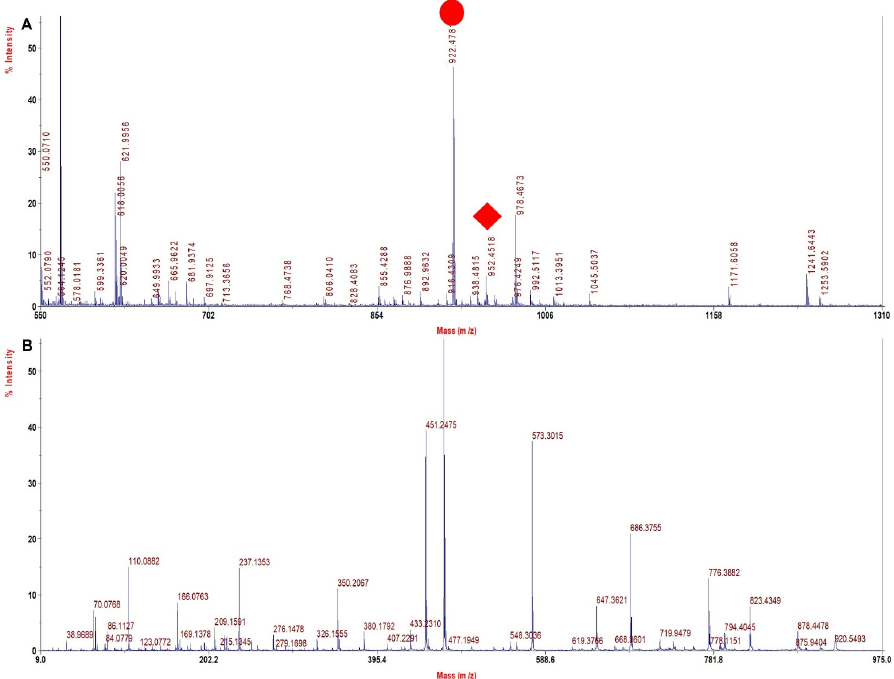
Figure 6. MALDI − MS and MALDI MS/MS spectra for the signature peptide from HbS heterozygous (1908) Beta 6 (A3) Glu > Val ( A ). PMF spectrum showing signature peptide obtained by TFE treated in − solution tryptic digestion. ( B ) MALDI − MS/MS spectrum of the signature peptide 922.4 m/z of HbS heterozygous sample. Figure 7A depicts the MS spectrum of HbS homozygous β 6 (A3) Glu > Val showing the tryptic peptide V 1 HLTPVEK 8 of monoisotopic m/z of 922.47. The MS/MS spectrum of the signature tryptic peptide VHLTPVEK is shown in Figure 7B. In β tryptic digested pep- tide VHLTPVEK of the HbS heterozygous sample, the difference between y (3 − 2 ion) in the normal and the mutated one was 30 Dalton, which indicated that glutamic acid was replaced by valine (Glu 6 → Val 6 ). The sequence coverage obtained from detailed MS/MS analysis was 70.4% in α chains and 100% in β chains with our database defined search in ProteinPilot software (Table 4).